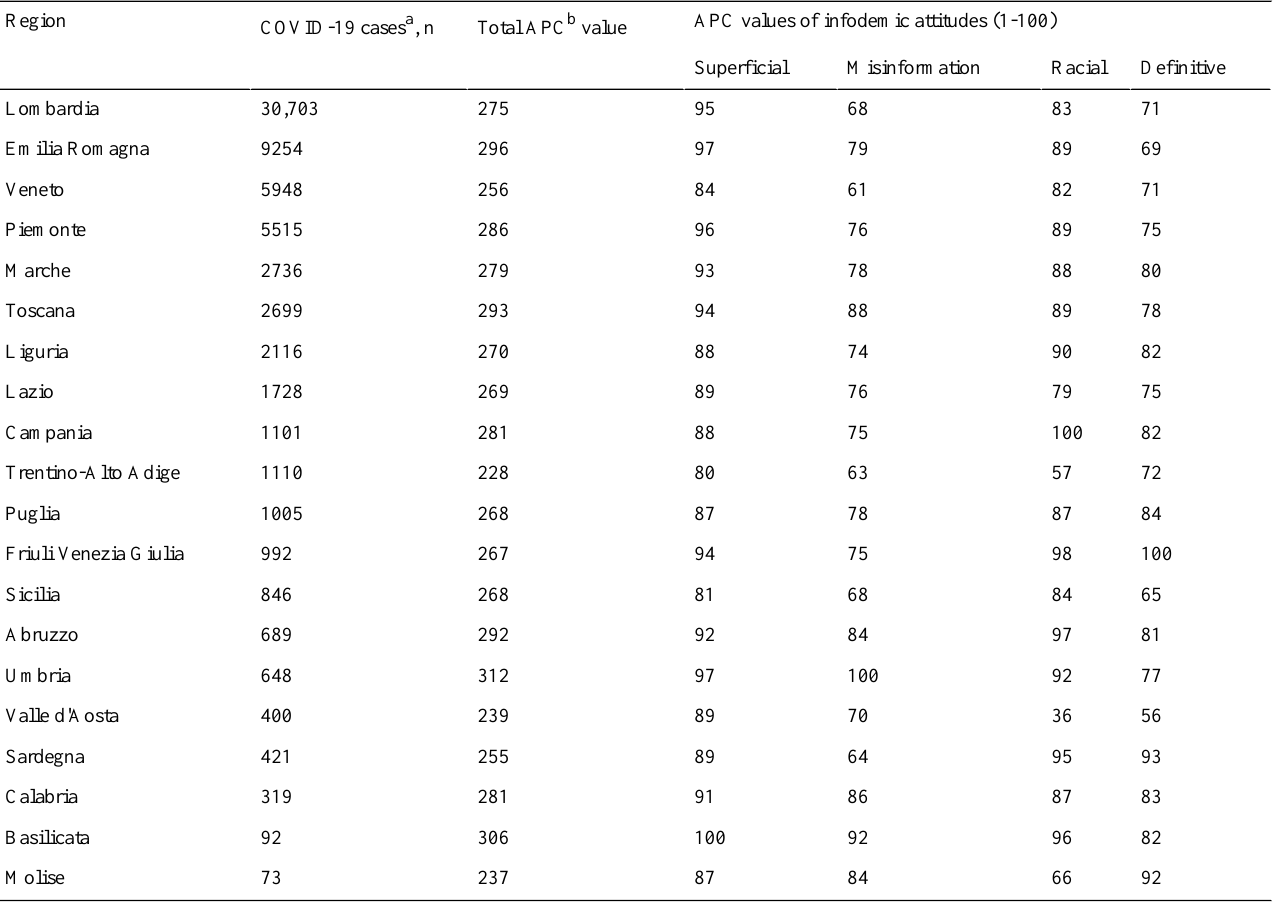
Table 1. Attitudes of infodemic monikers on coronavirus disease (COVID-19) in circulation across Italy between January 21, 2020, and March 24,